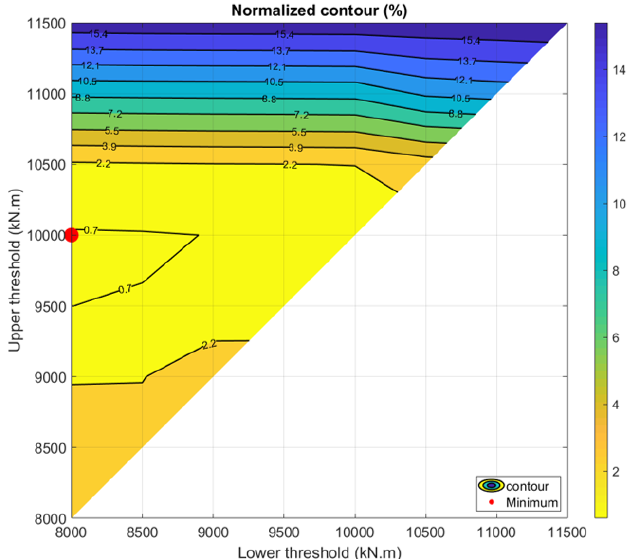
Figure 10. Weighted sum of the %-changes of the primary